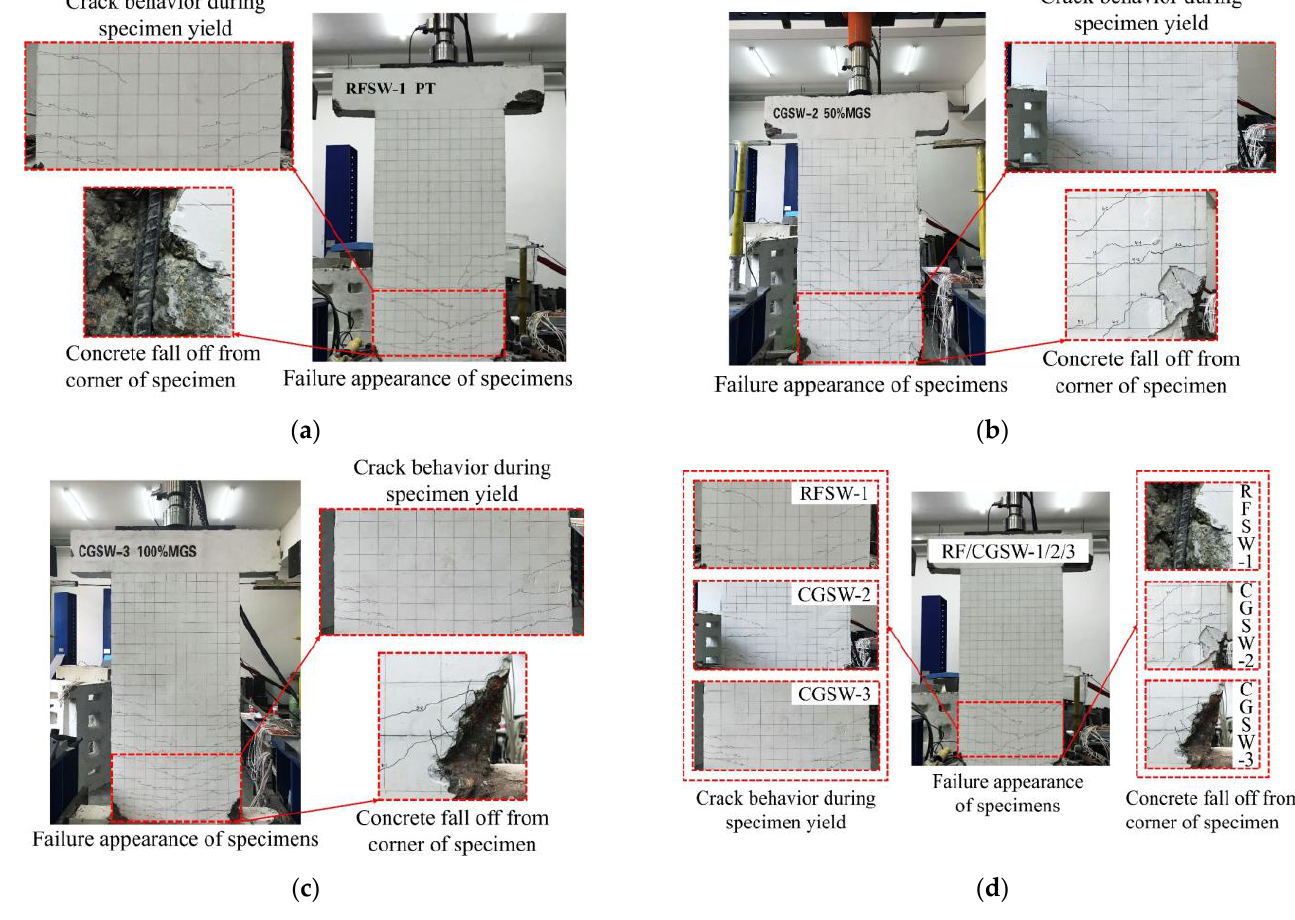
Figure 8. Failure morphology of the specimens ( a ) RFSW-1 ( b ) CGSW-2 ( c ) CGSW-3 ( d )